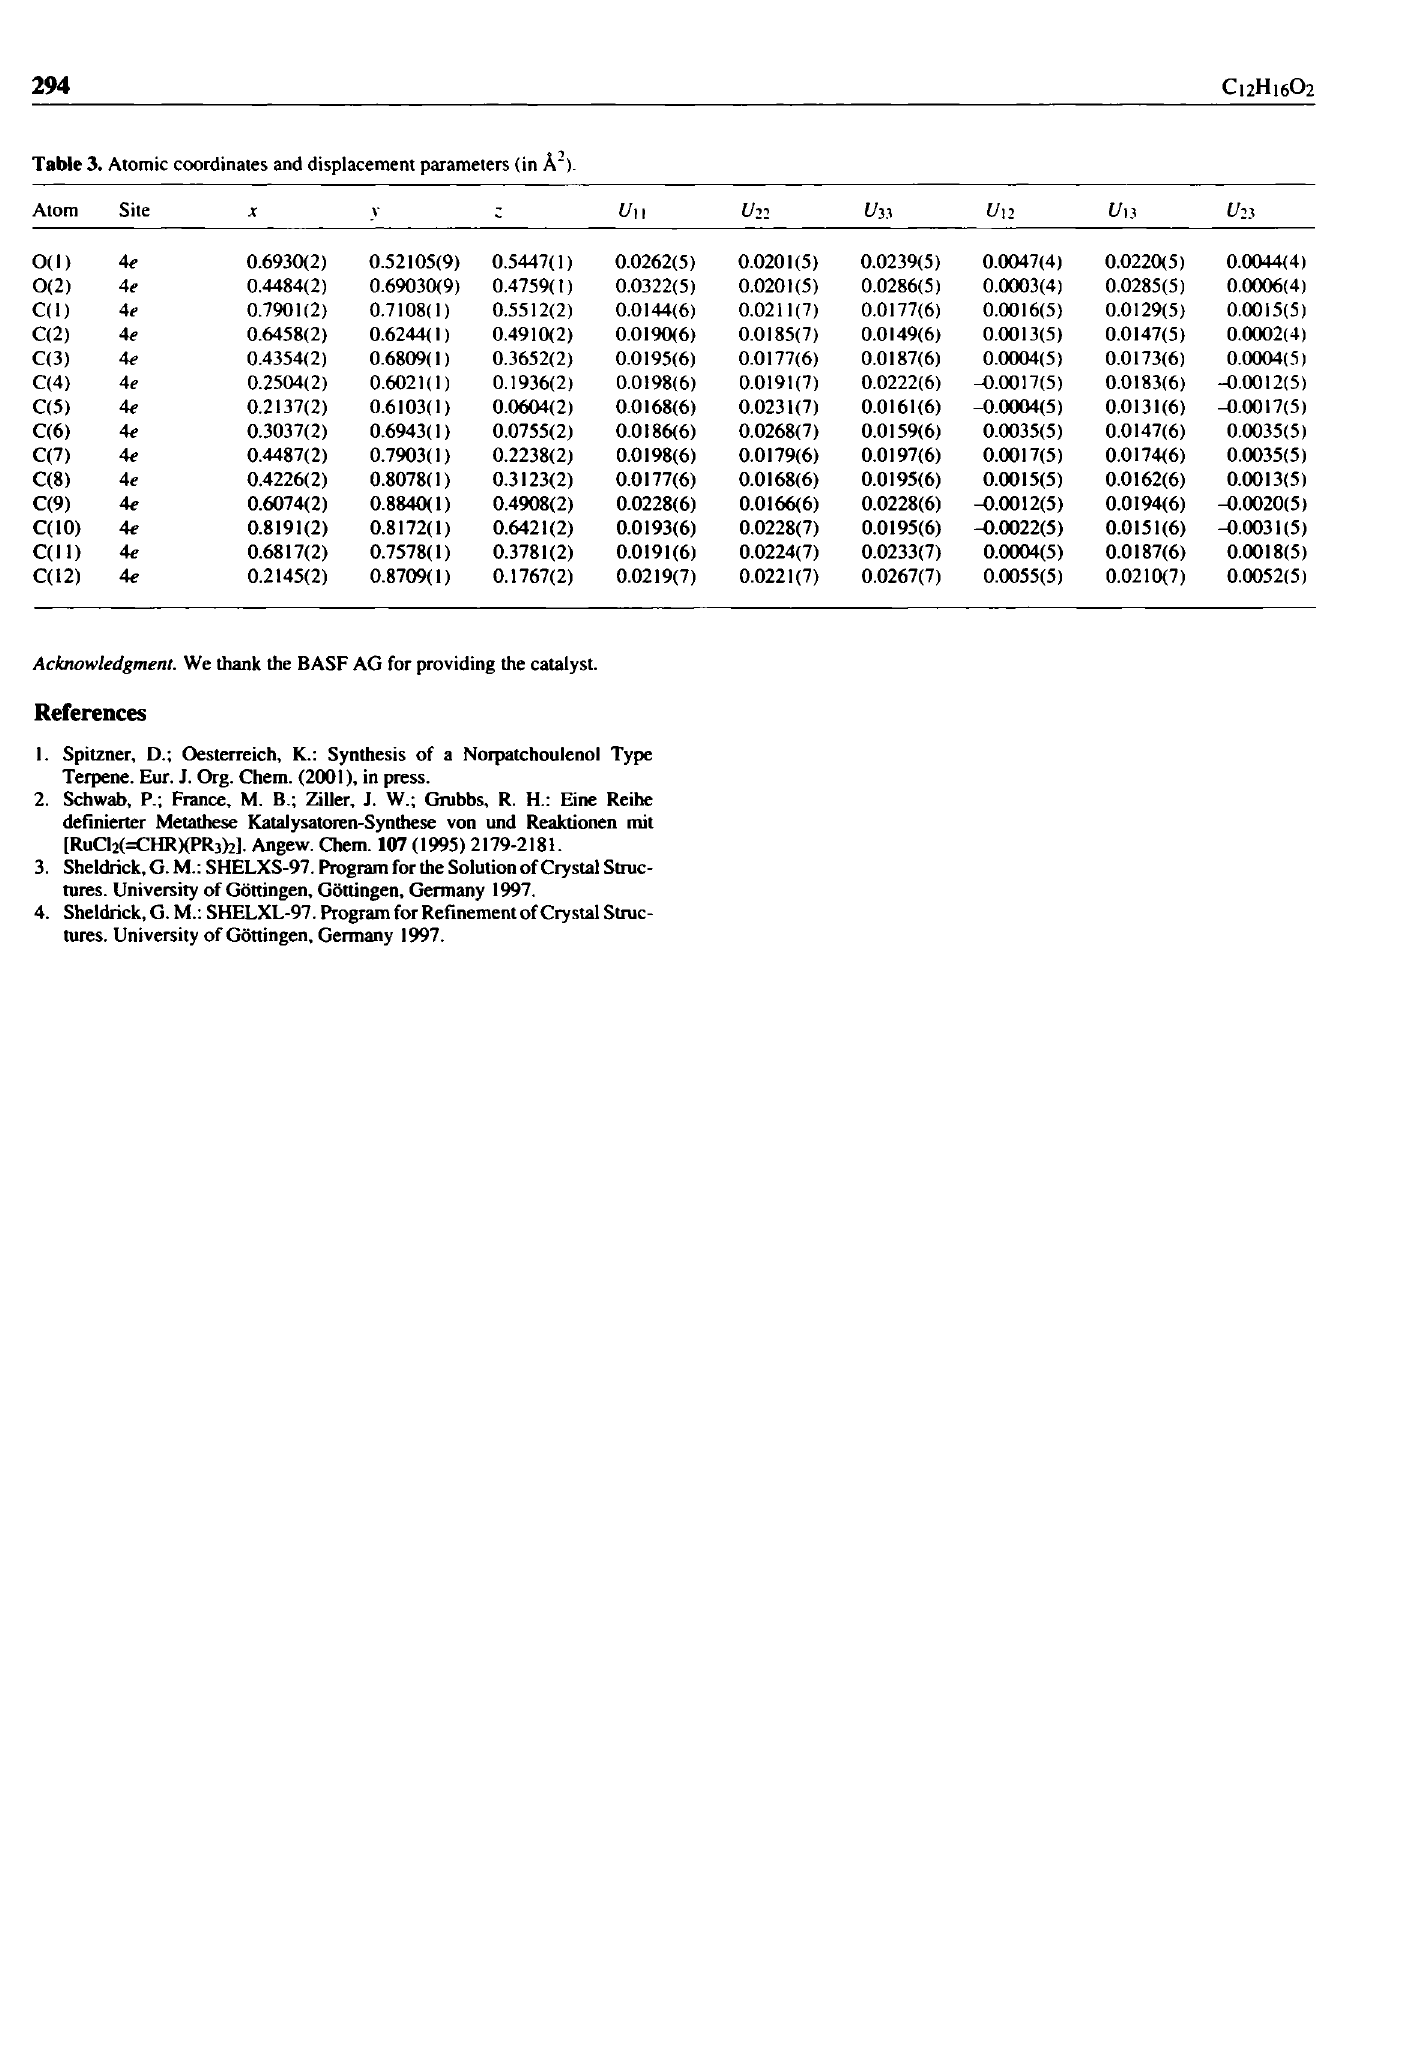
Table 3. Atomic coordinates and displacement parameters (in Ä 2